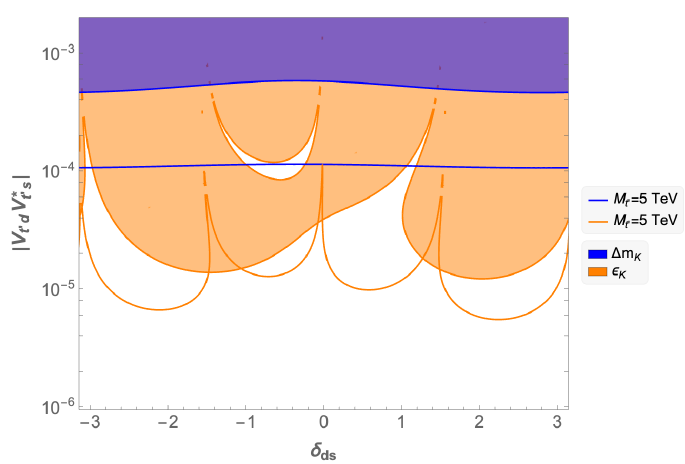
Figure 14 . Upper limits on the product | V ∗ V t 0 d | from neutral kaon mixing, obtained from the t 0 s constraint in eqs. (5.22), (5.24) with ∆ K = 1 , ∆ (cid:15) = 0 . 4 , as a function of the relative phase K δ ds = arg( V ∗ V t 0 d ) . The blue and orange lines indicate where the upper limit shifts for M t 0 = 5 TeV. t 0 s